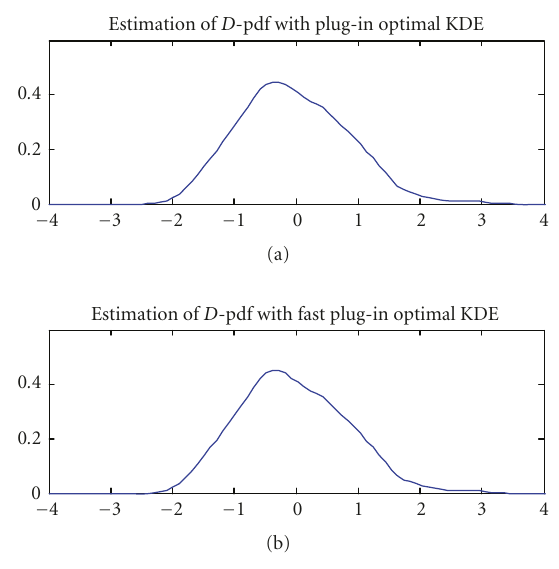
Figure 6: Estimation of the D -pdf of Testour by optimal plug-in KDE and fast plug-in